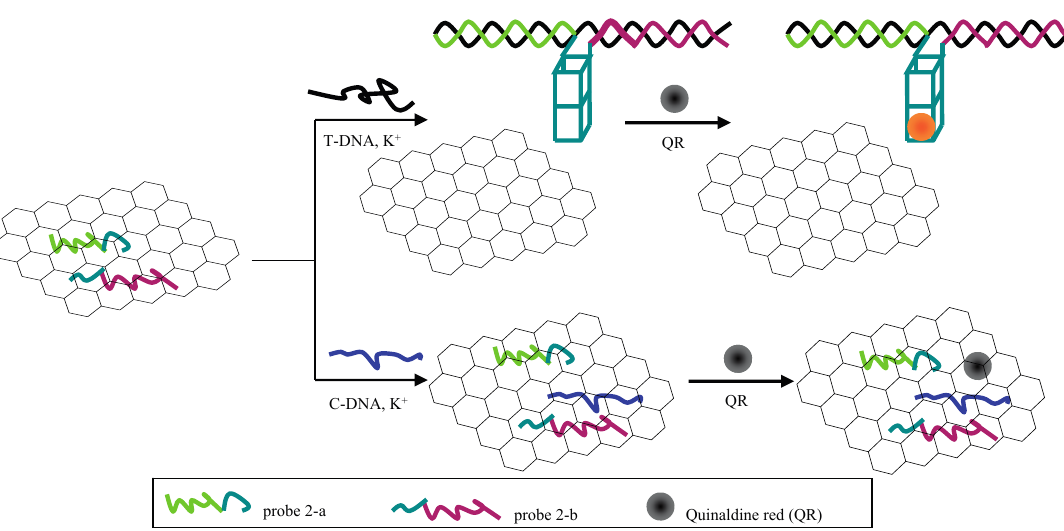
Scheme 1. Principle of the split G-quadruplex/GO platform for fluorescence identifying